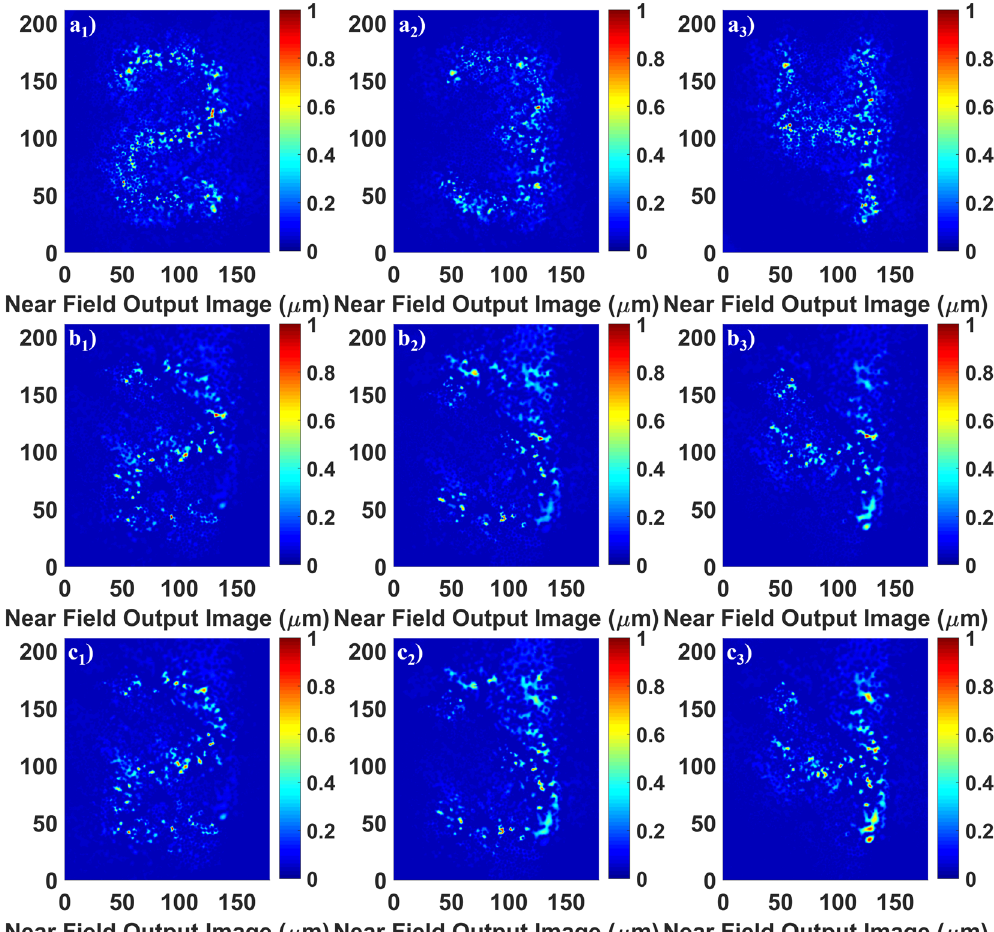
Figure 2. Transported images of different numbers of group 3 on the 1951 USAF test target. ( a1 – a3 ) Show transmission through a 4.5 cm straight GARF(1) sample; ( b1 – b3 ) show transmission through a 90 cm straight GARF(1) sample; ( c1 – c3 ) show transmission through the same 90 cm GARF(1) sample with a 180 degree turn (20 cm bending radius). The wavelength is 405